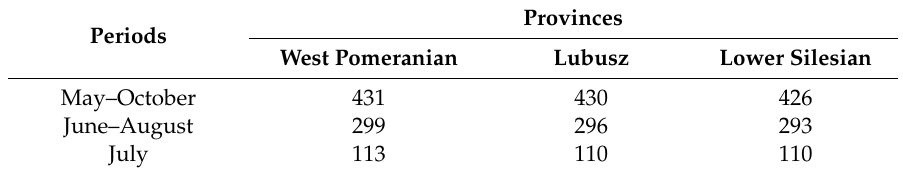
Table 4. Water needs (mm) of grapevines in the years 1981–2010 in the provinces of western Poland.